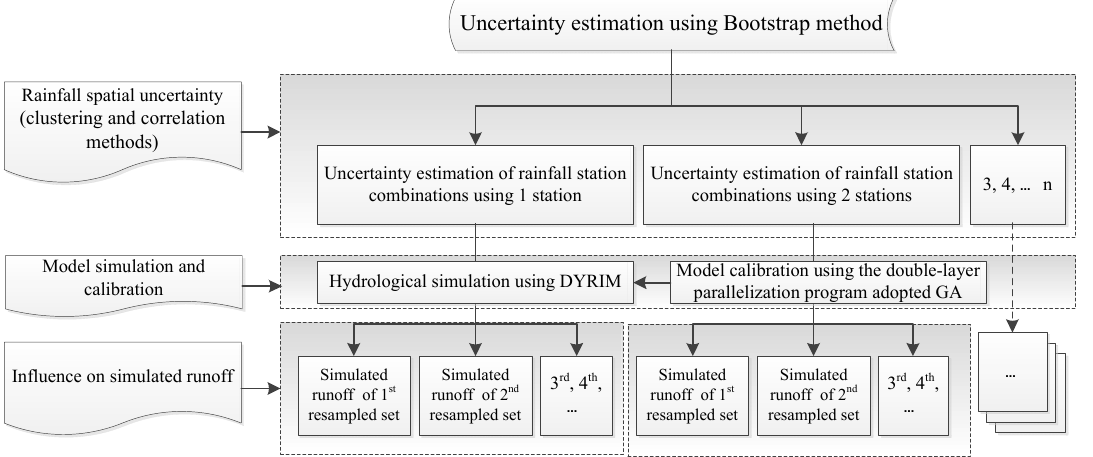
Figure 2. The flow chart of the uncertainty estimation using Bootstrap method.